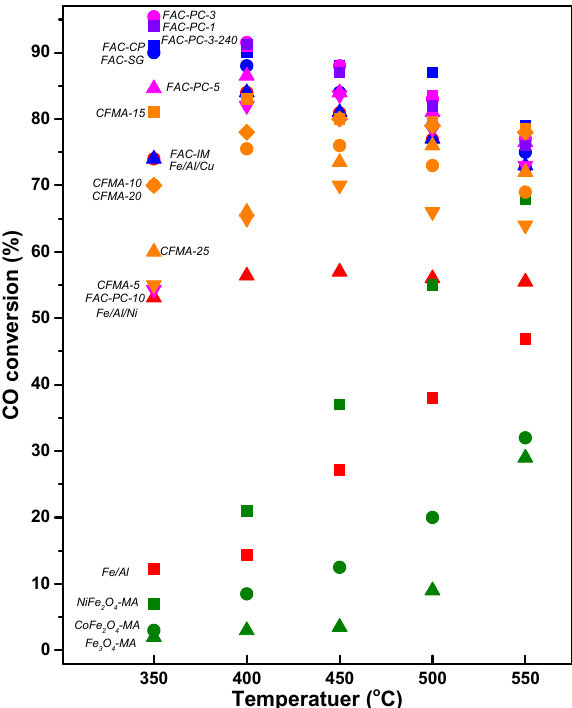
Figure 2. XPS spectra of the fresh FAC catalysts prepared by different methods. ( a ) Fe 2p; ( b ) Cu 2p. Adapted from Ref. [11]. Copyright 2015 Elsevier.